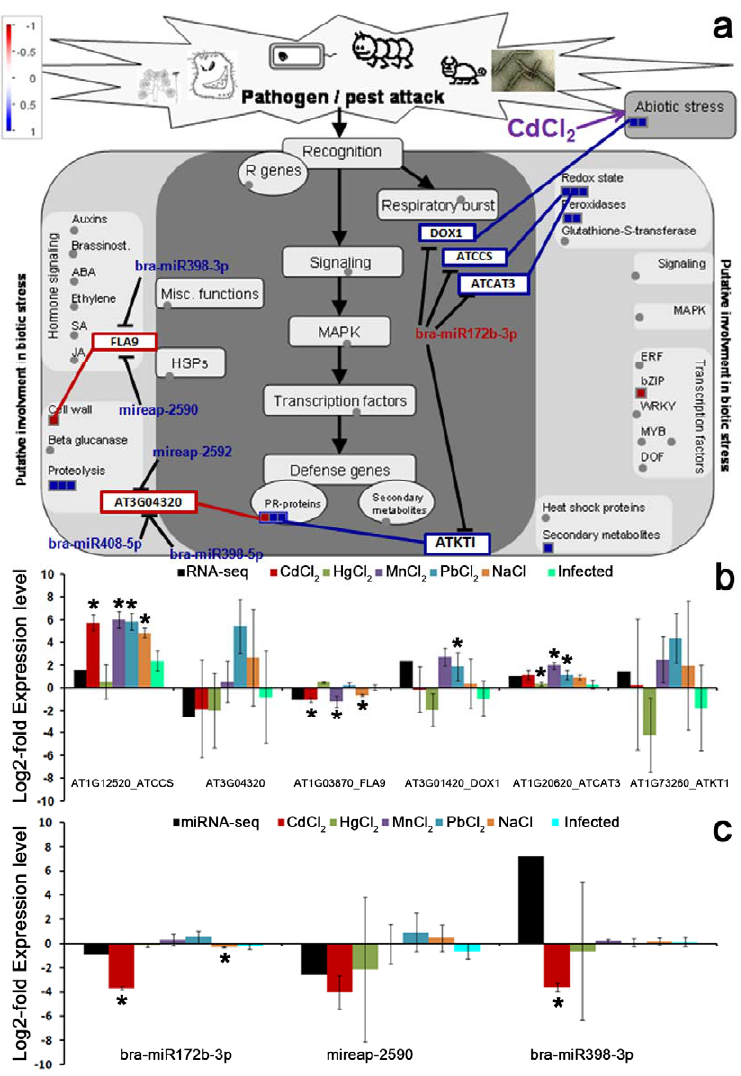
Figure 7. Verification of Cd stress in Brassica juncea and Cd-responsive miRNAs, and target genes from the biological pathway network (* p < 0.05): ( a ) Changes of expression in plant samples in response to pathogens visualized using MapMan. ( b ) Changed expression levels of identified unigenes and microRNAs ( c ) under different conditions.